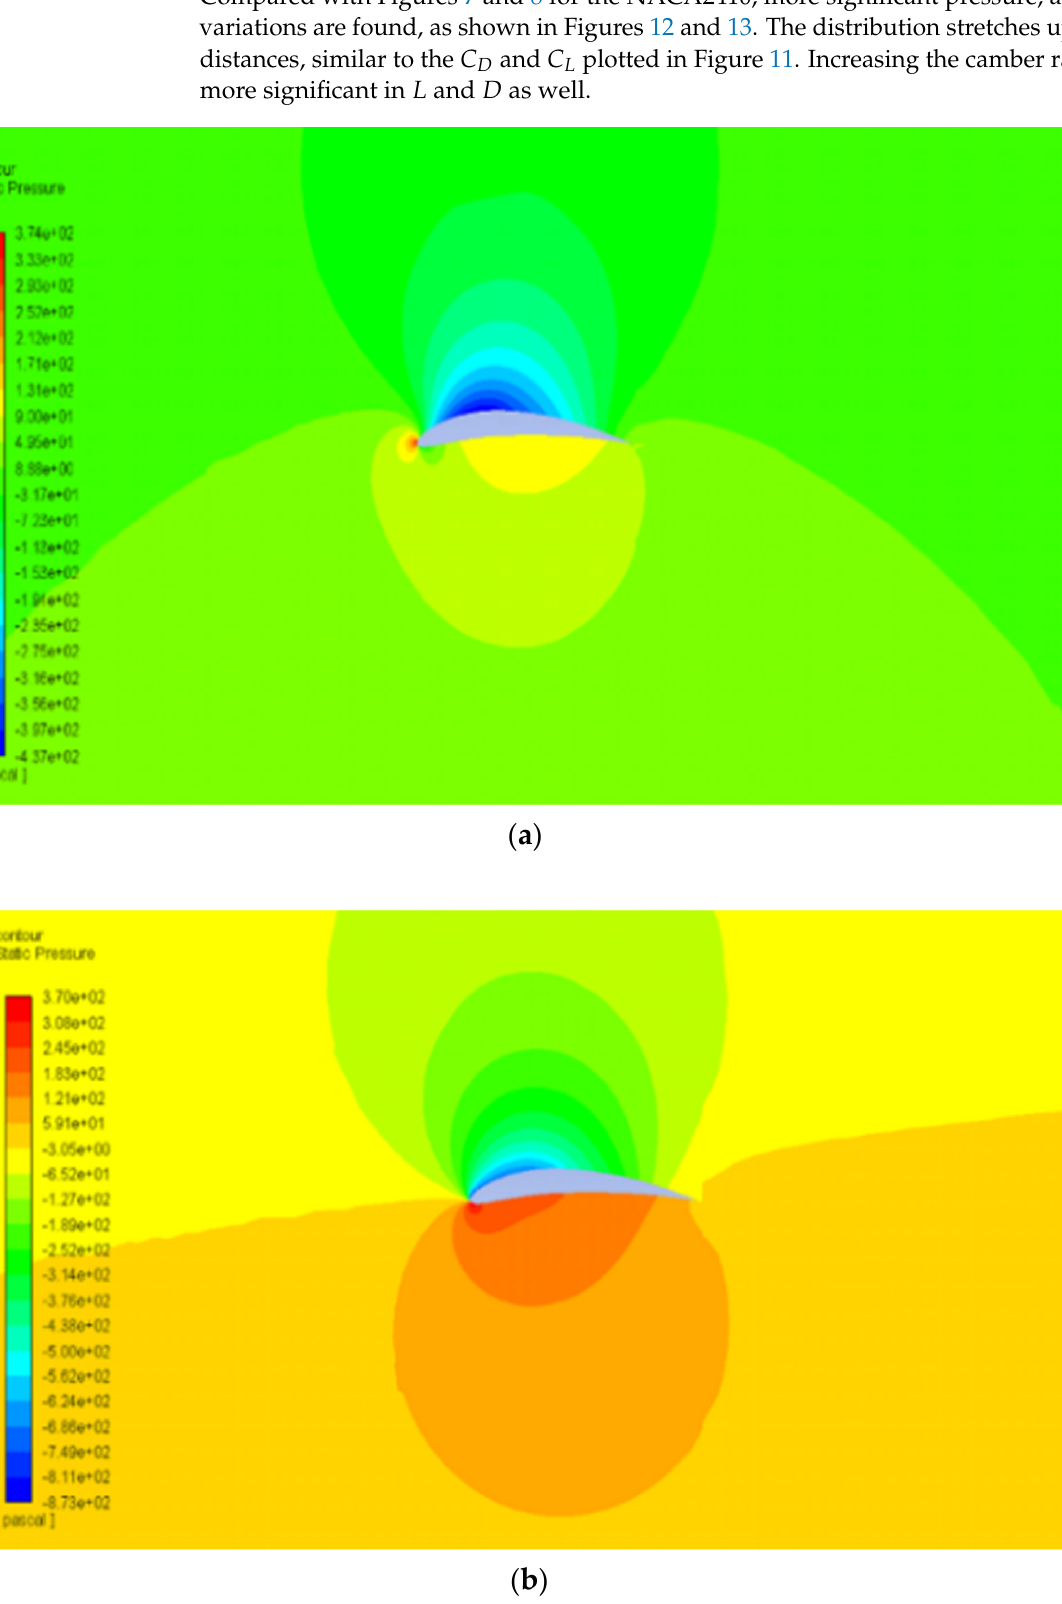
Figure 11. 𝐶 (cid:3005) and 𝐶 (cid:3013) of NACA2410 and NACA8410 vs. varying AoA.